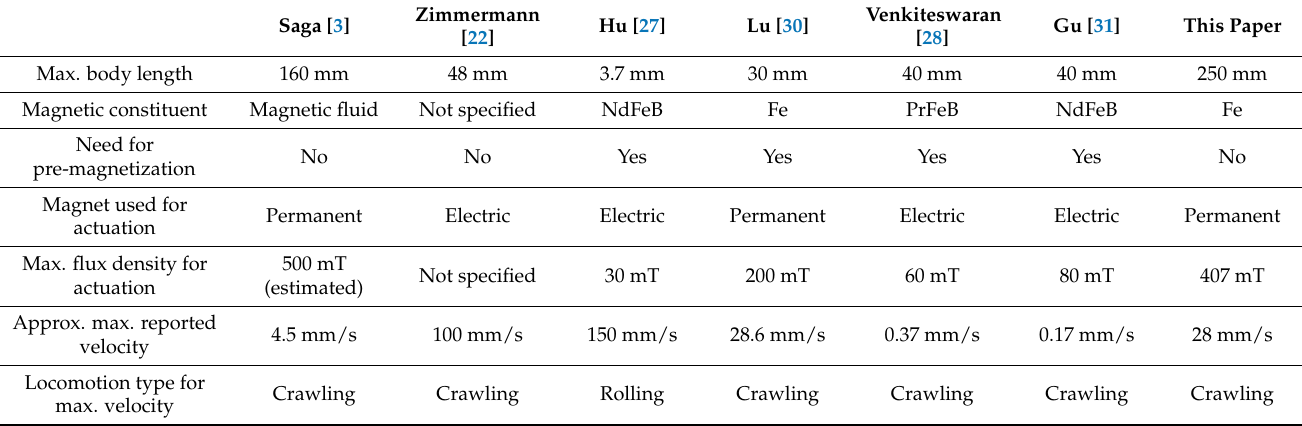
Table 1. Comparison of different reported soft magnetic robots. Although the locomotion types are only classified into two catergories, each of the robots mentioned in this table moves in a quite distinctive manner, which also affects its maximum